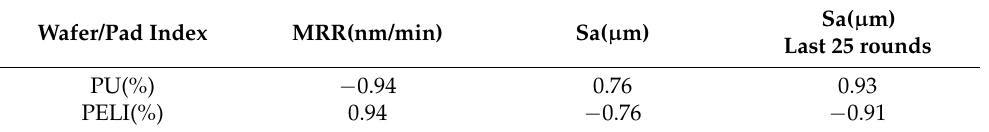
Figure 17. The correlations between wafer Sa and PELI. Table 6. Correlations of Wafer and pad index.